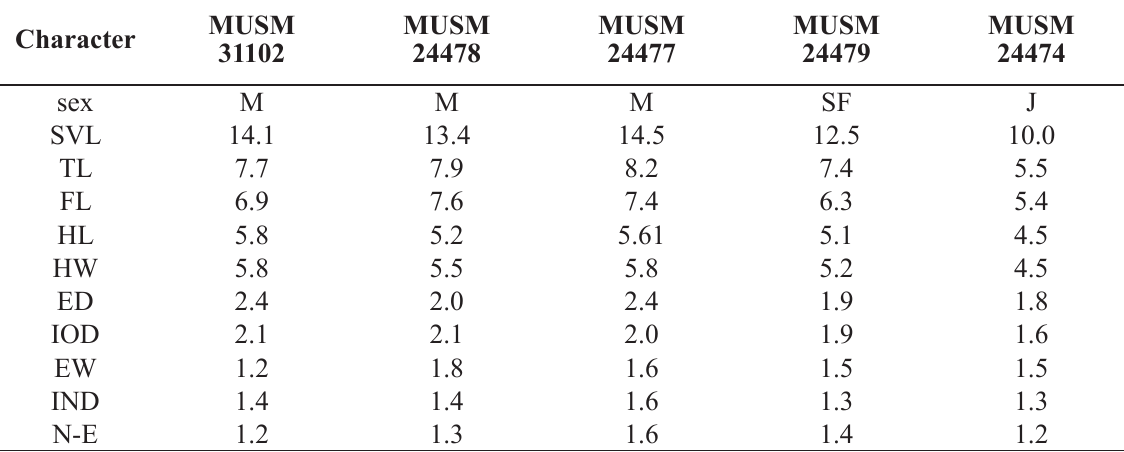
Table 3 . Measurements (in mm) of the type series of Pristimantis boucephalus sp. nov. Abbreviations: M = ♂; SF = subadult ♀; J = juvenile. For other abbreviations see Material and